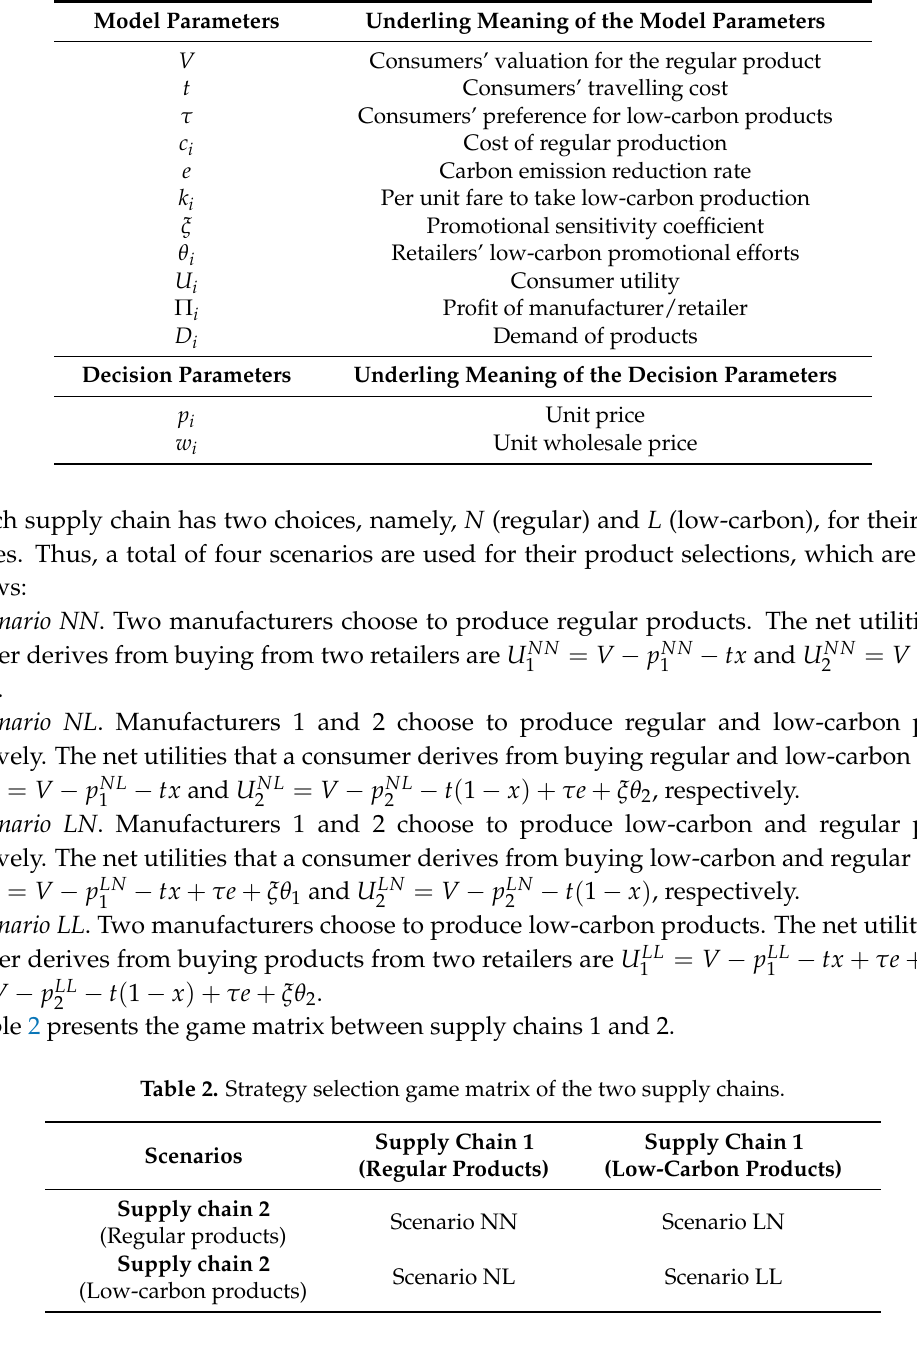
Table 1. Notations for the parameters and variables.